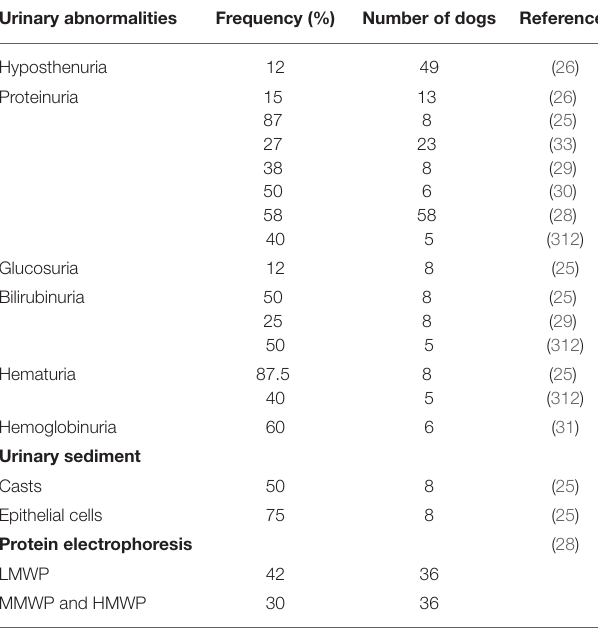
TABLE 5 | Urinary abormalities associated with granulocytic anaplasmosis after natural infection and corresponding frequency recorded in several